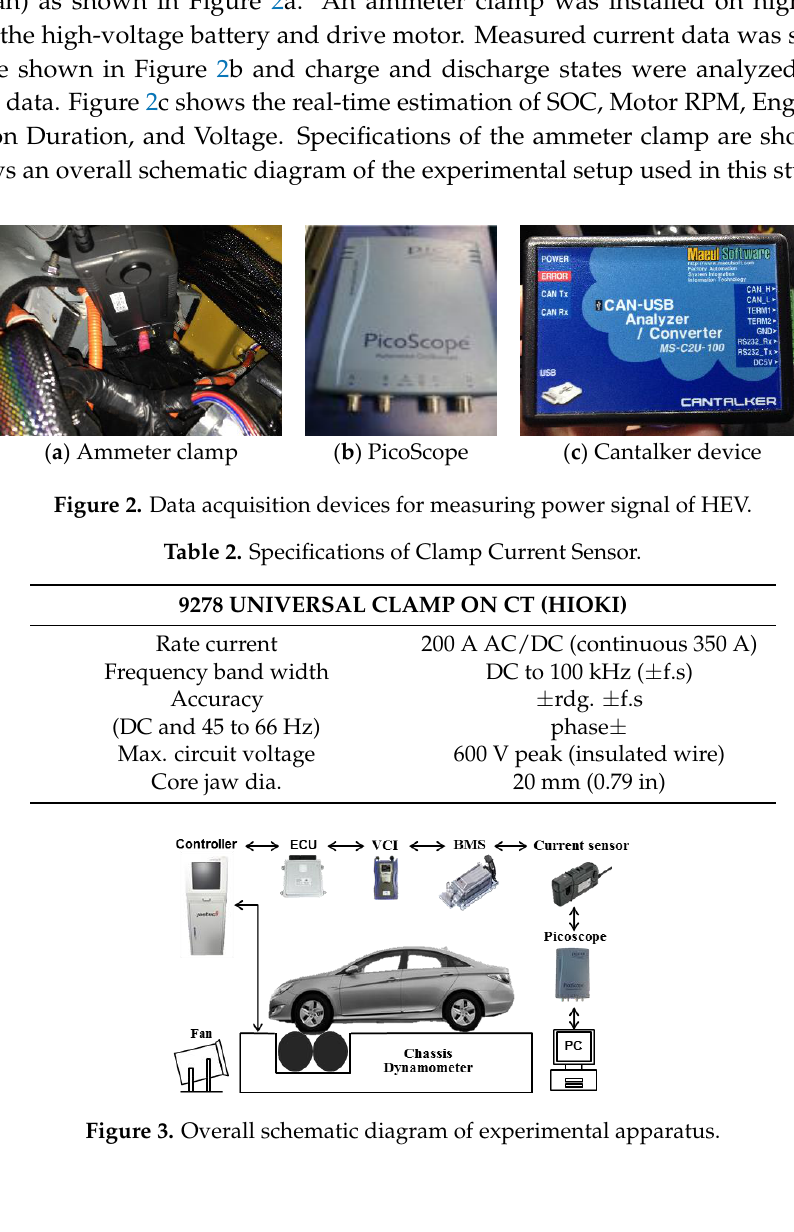
Table 1. Specifications of HEV used in this study.